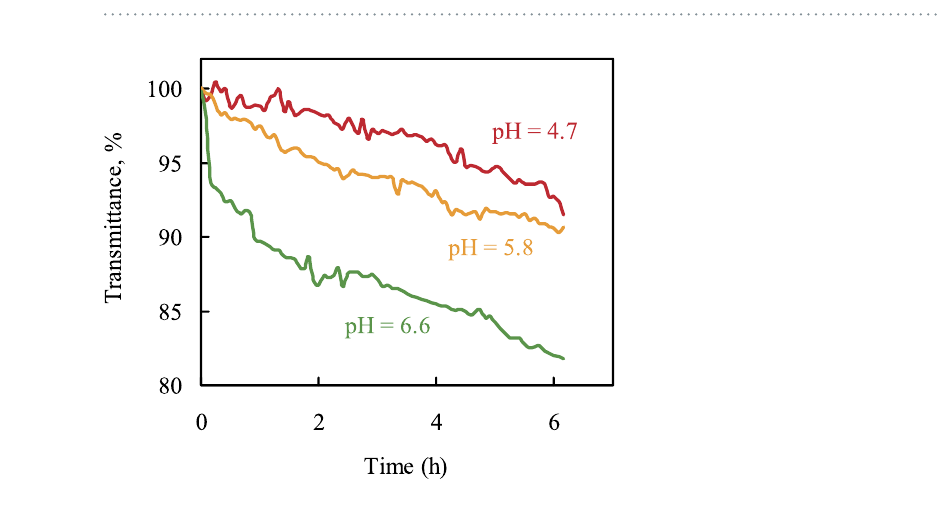
Figure 3. Effect of the exposed core length on the transmittance response monitored by the fiber optic sensor as a function of time after exposure to geothermal water in Sumikawa Geothermal plant, Japan. Wavelength: 600 nm; exposed core length: 8 cm (red line), 16 cm (yellow line), and 24 cm (green line).